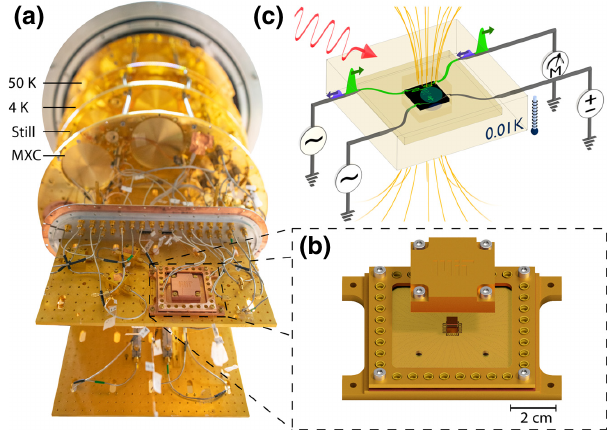
FIG. 1. Package environment, layout, and requirements. (a) Dilution refrigerator with multiple temperature stages holding the qubit chip enclosed in a microwave package. The microwave package interfaced with through microwave lines is mounted on a cold finger in the mixing chamber reaching a base tem- perature of approximately 10 mK. (b) The microwave package consists of a metal enclosing, microwave connectors, an inter- poser for signal fan out, and a microwave cavity in the center surrounding the quantum chip. (c) The purpose of a microwave package is to shield the enclosed qubit chip from external radi- ation (red oscillating arrow) and stray magnetic fields (yellow lines) while providing impedance-matched (transmitted green pulse and reflected blue pulse at the input and output), low- crosstalk communication channels (crosstalk in green at input), and a thermal link to the dilution